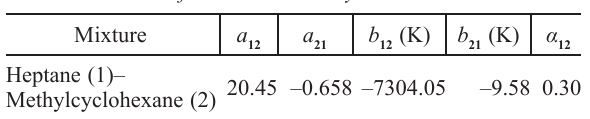
Table 5 – Binary interaction parameters of NRTL correlation model for all measured systems